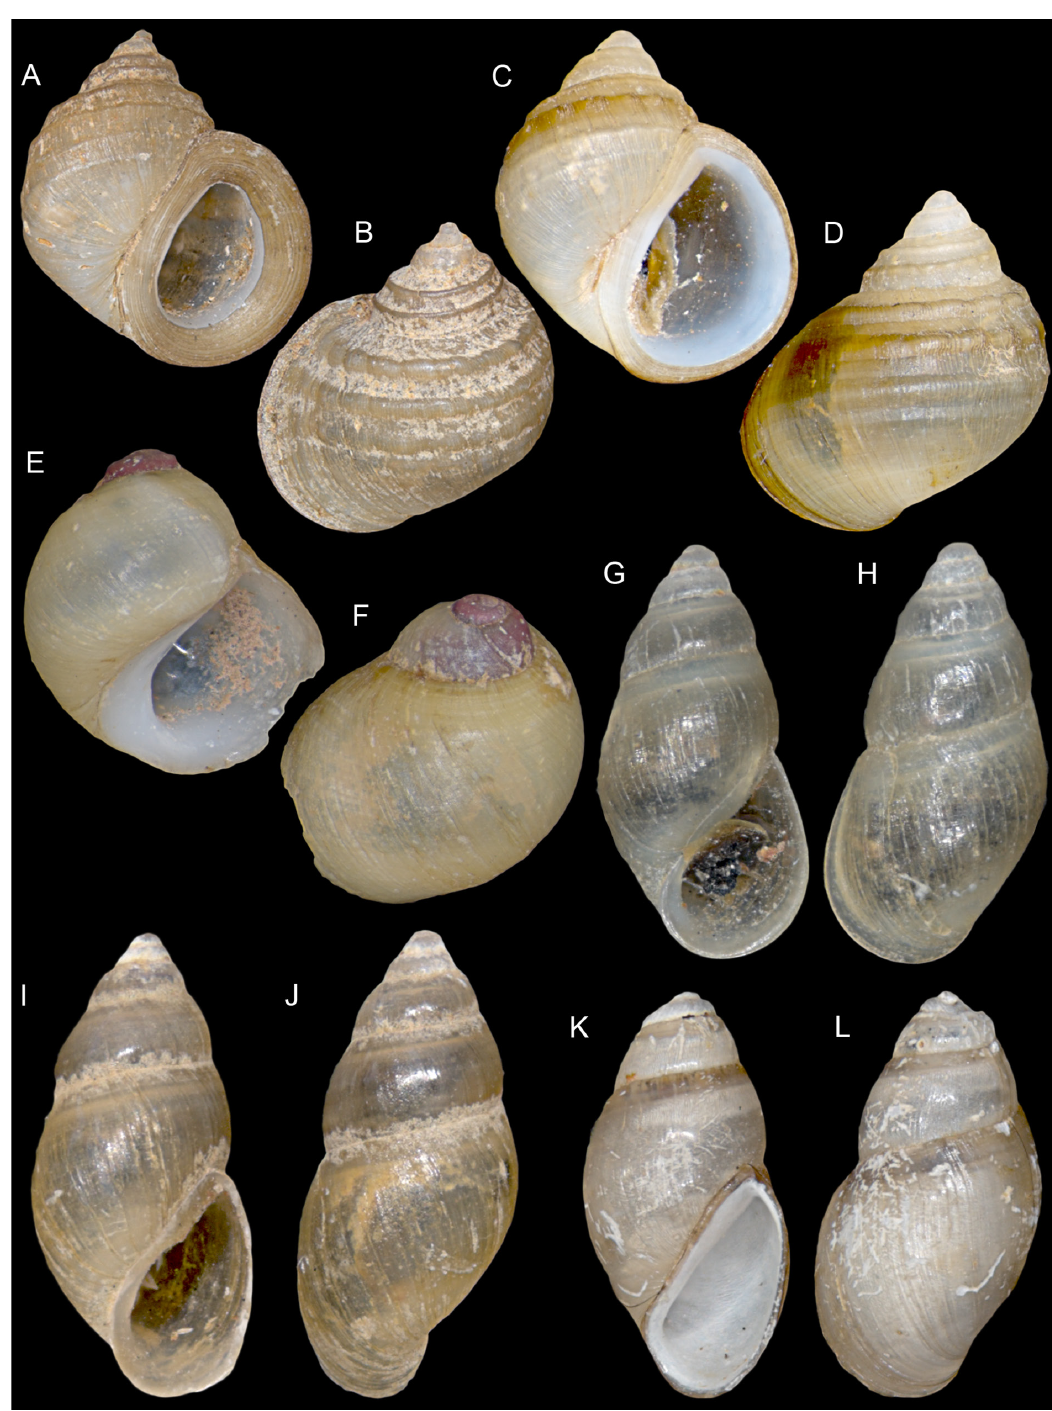
Fig. 4. A–B . Jullienia munensis Brandt, 1974, probable paratopotype MZSP 95482, L = 5.9 mm, W = 5.2 mm. C–D . Jullienia rolfbrandti Temcharoen, 1971, probable paratype MZSP 95463, L = 7.3 mm, W = 6 mm. E–F . Lacunopsis conica Brandt, 1968, probable paratype MZSP 95495, L = 5.3 mm, W = 4.9 mm. G–H . Hubendickia microsculpta Brandt, 1968, probable paratype MZSP 95945, L = 4.35 mm, W = 1.71 mm. I–J . Manningiella polita Brandt, 1970, probable paratype MZSP 95475, L = 4.2 mm, W = 2 mm. K–L . Manningiella rolfbrandti Temcharoen, 1971, probable paratype MZSP 95924, L = 4.2 mm, W = 2.2